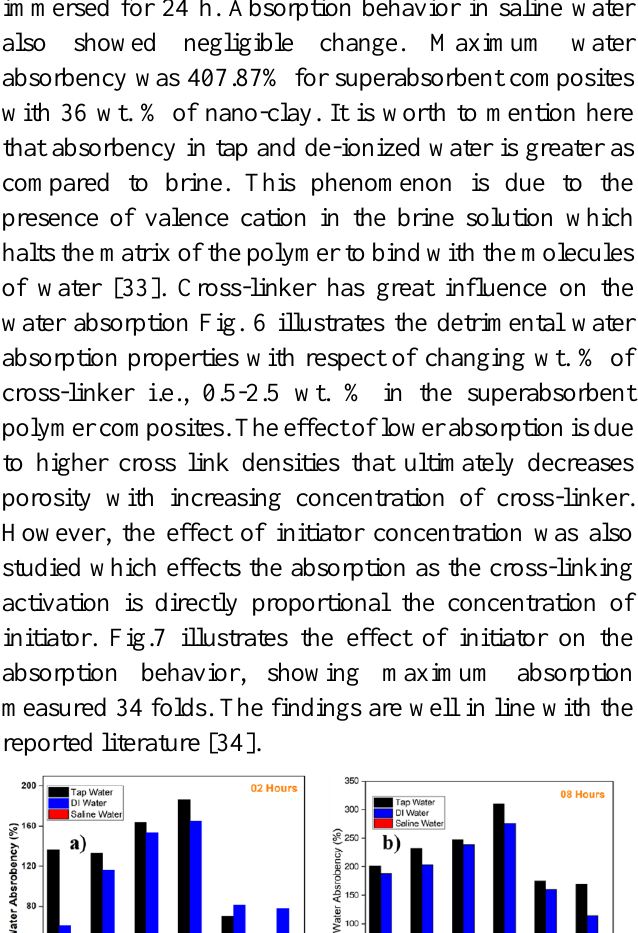
Fig. 4. EDX- Spectrum of 36 wt. % composites (SAPCs)